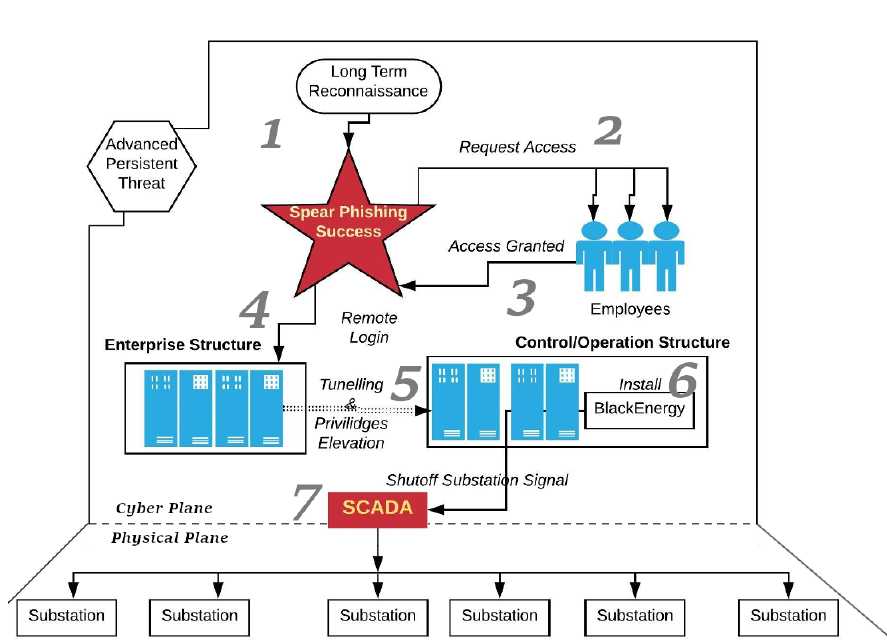
Figure 5. Targeting employees with socially engineered phishing campaigns, leading to remote